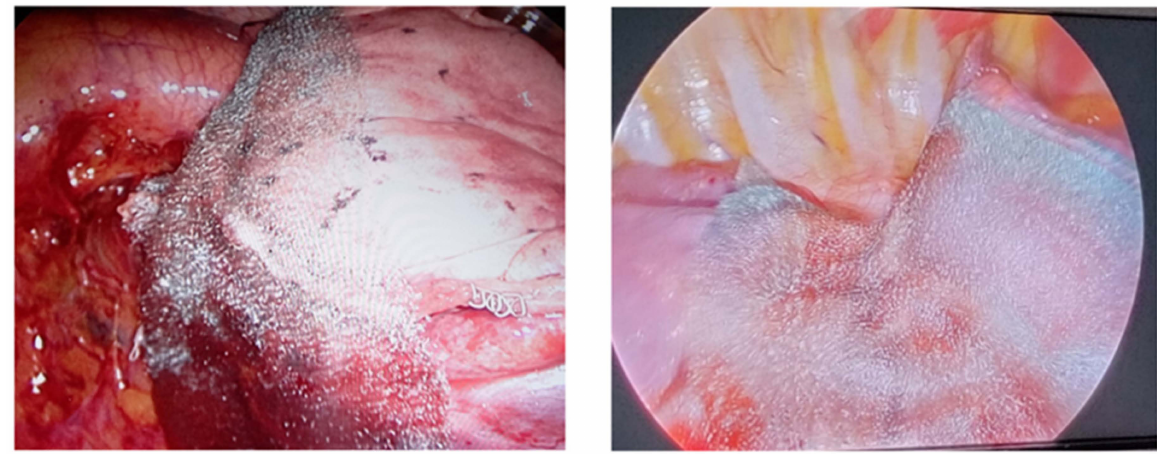
Figure 1. Neoveil sheets application on lung